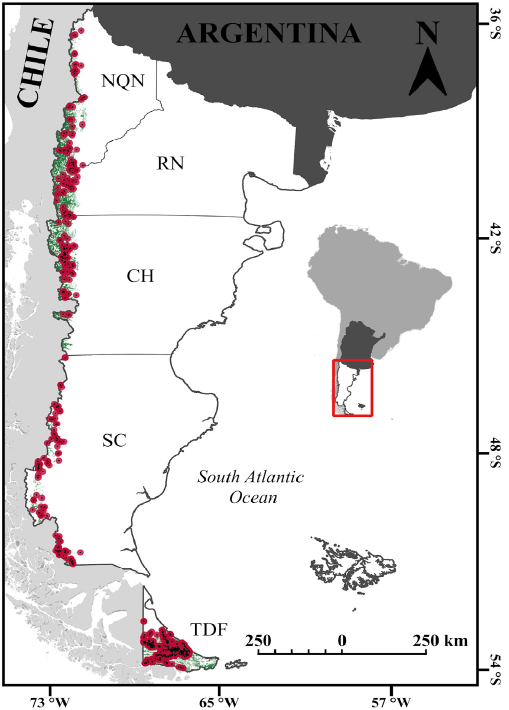
Figure 1. Location of the study area, indicating the sampled stands (black dots), and 10 km buffer (red area) and Patagonian forests of Argentina (green area) at the different provinces (TDF = Tierra del Fuego, SC = Santa Cruz, CHU = Chubut, RN = Río Negro, NQN = Neuquén).